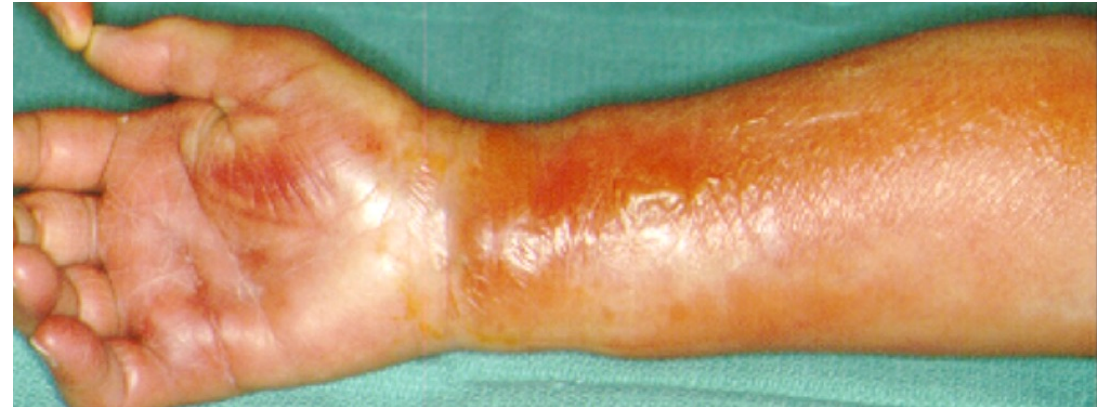
Figure 4. “Horse-shoe” abscess extended through the carpal tunnel, to the Parona’s space and the Figure 4. " Horse-shoe” abscess extended through the carpal tunnel, to the Parona ' s space and the distal distal forearm.